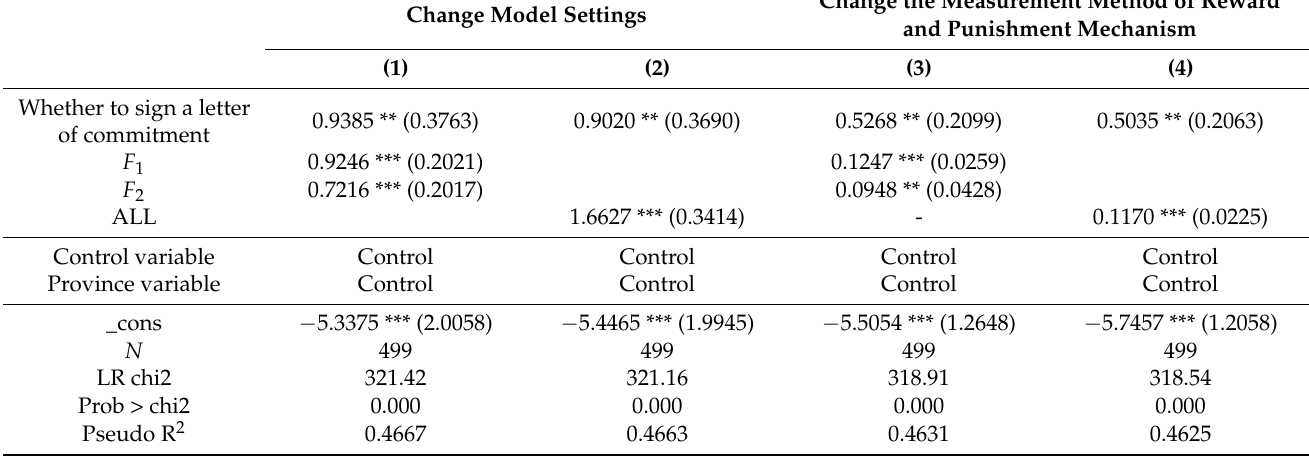
Table 5. Robustness